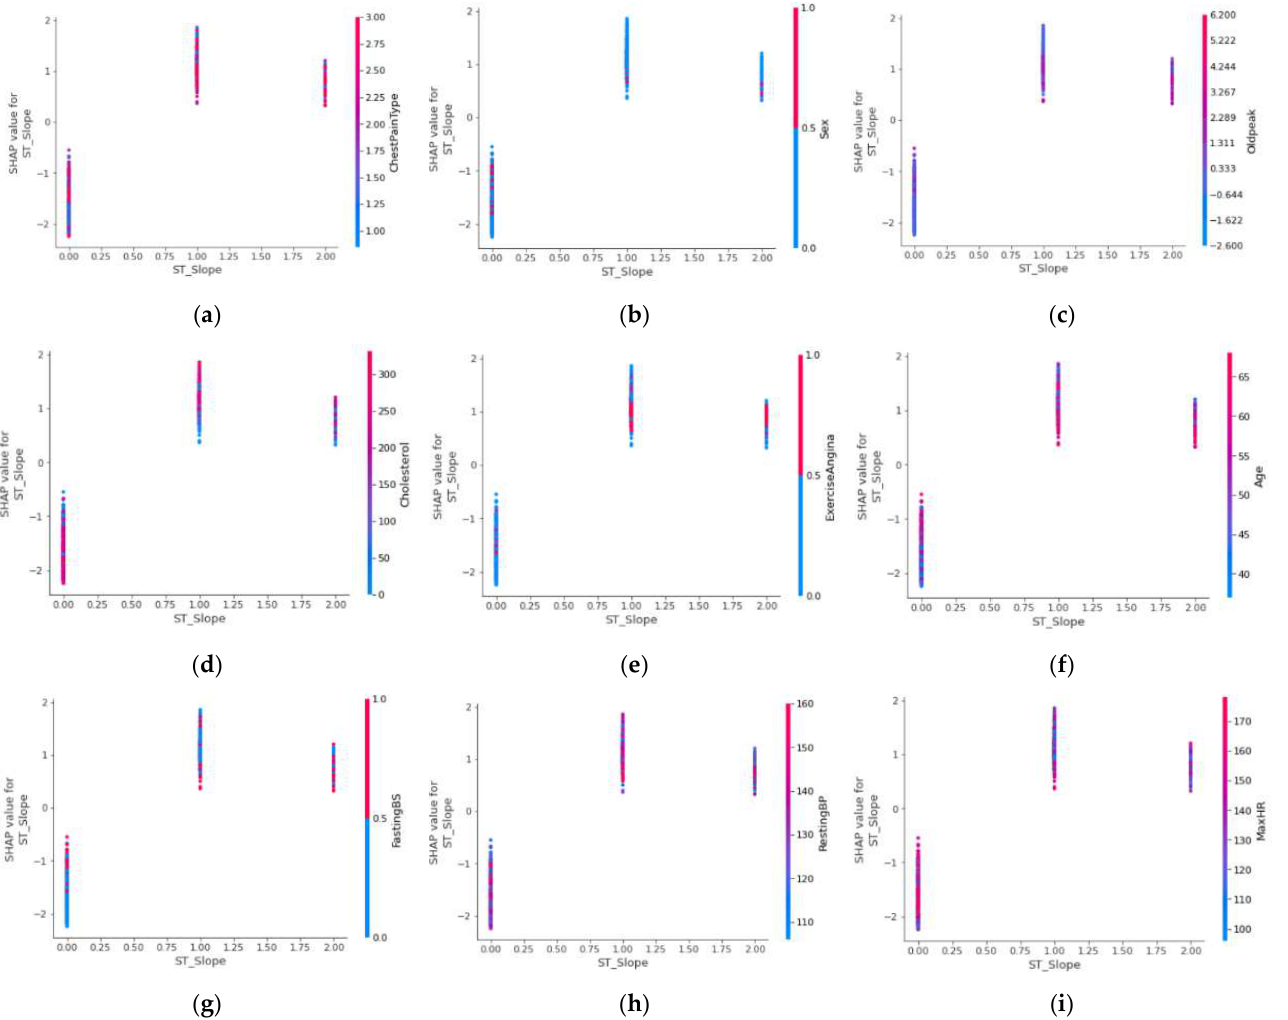
Figure 5. ( a ) “ST_Slope”and“ChestPainType” joint feature contribution. ( b ) “ST_Slope”and“Sex” joint feature contribution. ( c ) “ST_Slope”and“Oldpeak” joint feature contribution. ( d ) “ST_Slope”and“Cholesterol” joint feature contribution. ( e ) “ST_Slope”and“ExerciseAngina” joint feature contribution. ( f ) “ST_Slope”and“Age” joint feature contribution. ( g ) “ST_Slope”and“FastingECG” joint feature contribution. ( h ) “ST_Slope”and“RestingBP” joint feature contribution. ( i ) “ST_Slope”and“MaxHR” joint feature contribution.